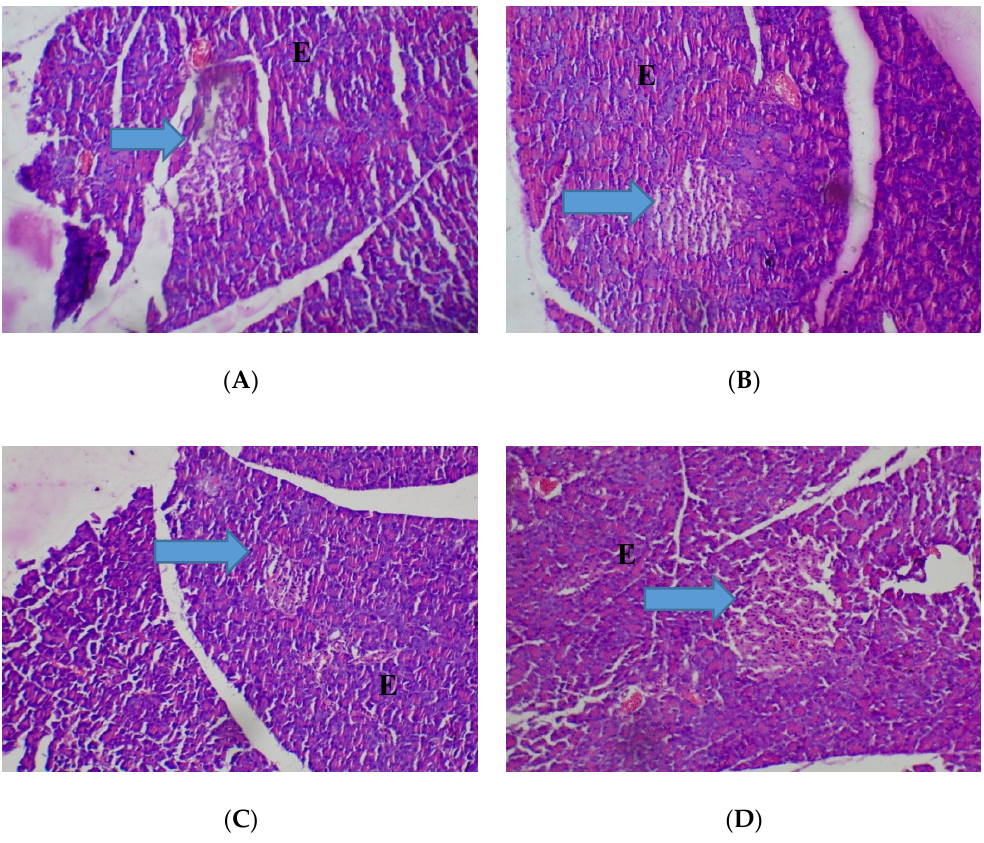
Figure 6. Histopathological presentation of rat pancreas. ( A ) represents the control group treated with distilled water (Normal); ( B ) represents the group treated with 80 mg/kg T. occidentals extract (Normal); ( C ) represents the group treated with 400 mg/kg T. occidentalis extract (Normal) and ( D ) represents the group treated with 2000 mg/kg T. occidentalis extract (Normal) ( × 400). The slides show normocellular islets (see arrow) surrounded by normal appearing exocrine acini ( E ). No necrosis is seen. In respect of the spleen, histopathological presentations showed normal lymphoid follicles (80–2000 mg/kg) (Figure